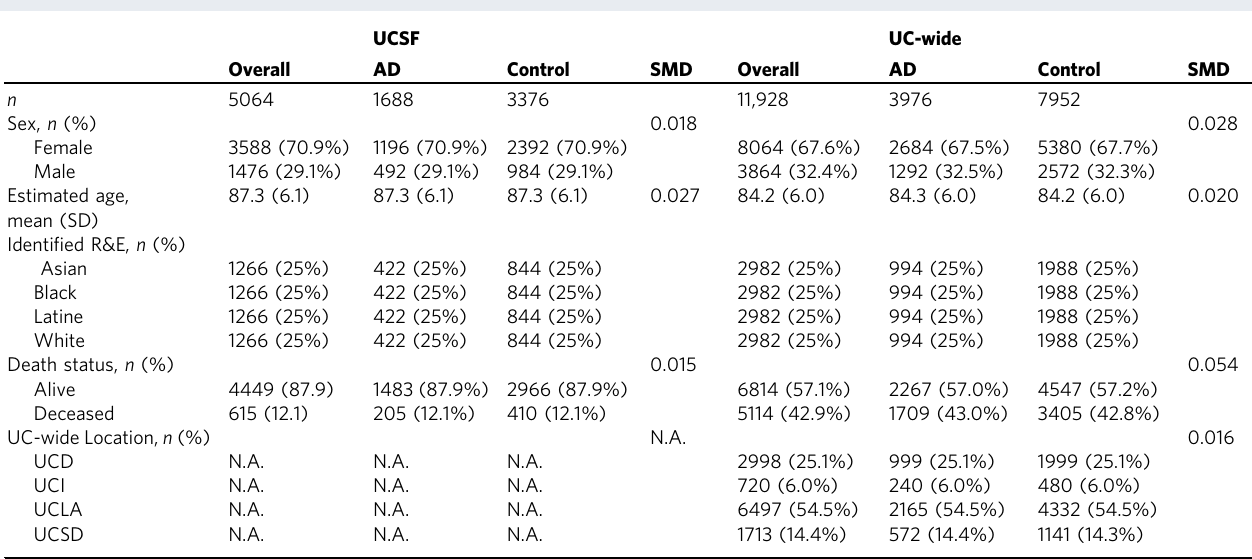
assess whether there were global differences by AD status, R&E categories, and UC location. UMAP component means and standard deviations based on AD status, identi fi ed R&E, and UC location are provided in Supplementary Data 1.